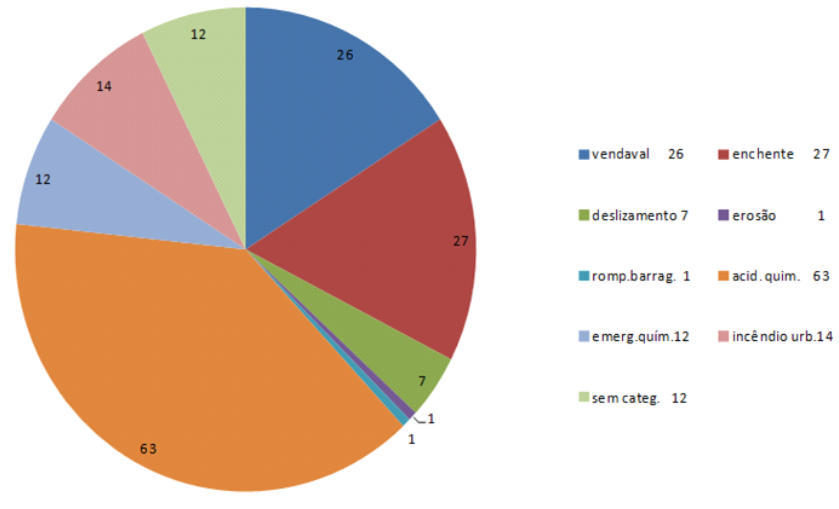
Figure 12. On line notifications sent by CENTRAL-CIEVS to DOMA, Mar 2011–Mar 2012. (39% Chemical accidents; SOURCE: